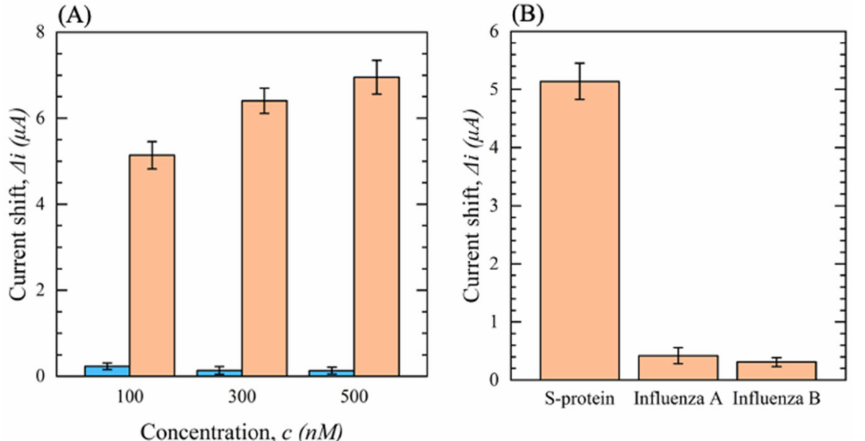
Figure 11. ( A ) Current shift ( ∆ i ) of functionalized sensors with S1-Ab (orange) and mouse IgG (blue)